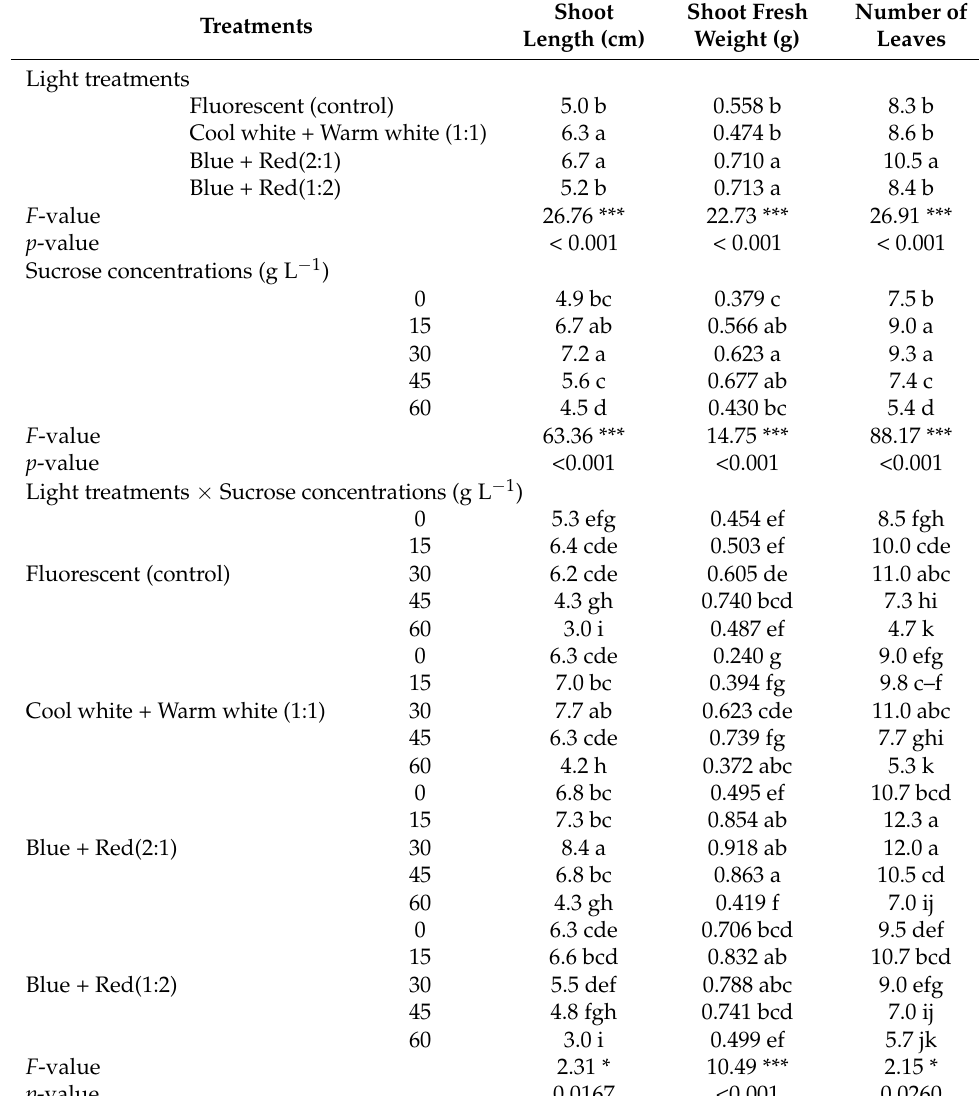
Table 2. Effects of light spectra and sucrose concentration treatments on the shoot length, shoot fresh weight, and number of leaves of in vitro blackberry plantlets.